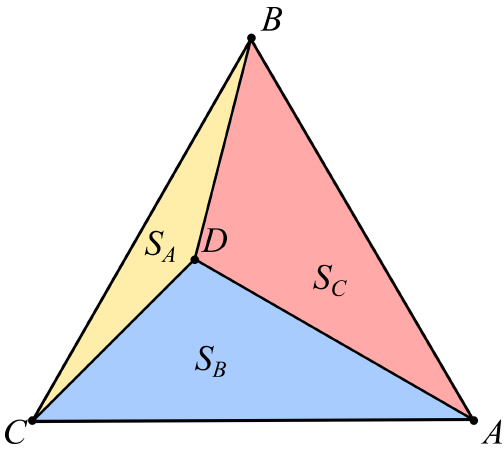
Figure C1. Geometry of triangular barycentric